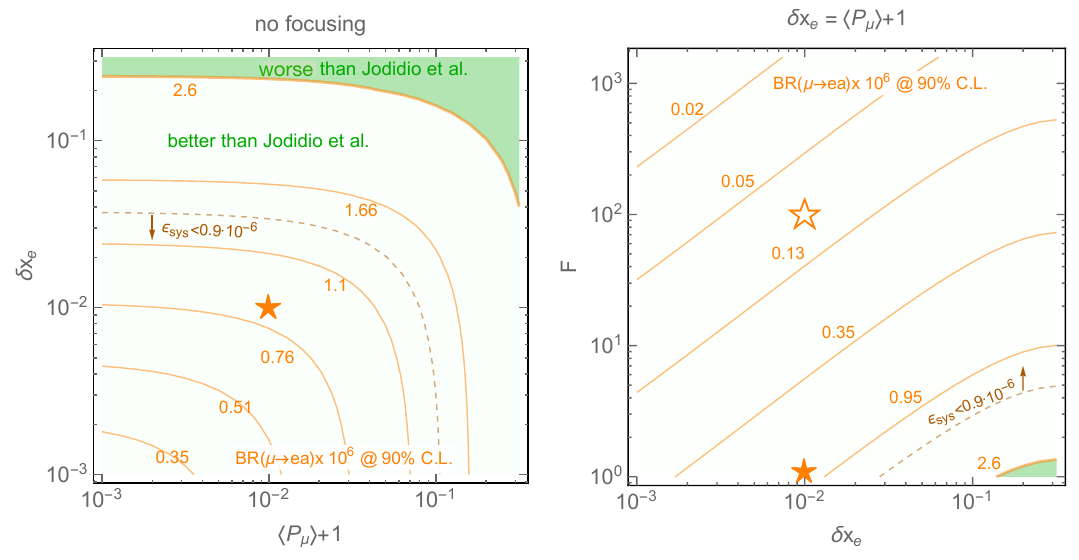
Figure 6 . Left: The orange contours show the 90% C.L. expected sensitivity on BR ( µ + → e + a ) at MEGII-fwd for a massless isotropic ALP (either C V 6 = 0 or C A 6 = 0 ) as a function of the µe µe momentum resolution δx , and the deviation of average polarization h P from − 1 , assuming there is e µ i no magnetic focusing. Right: The expected sensitivity at MEGII-fwd ( orange contours) as a function of the momentum resolution δx and focusing F , setting muon polarization to h P = − 1+ δx . The e µ i e angular resolution is assumed to be subdominant and systematic uncertainties below the statistical one. The darker green region are excluded by the 1986 Jodidio et al. experiment [9], cf. table 1. The dashed dark orange line indicates where our future projections assume that systematic uncertainties can be lowered compared to the ones in Jodidio et al. (cid:15) = 0 . 9 × 10 − 6 sys